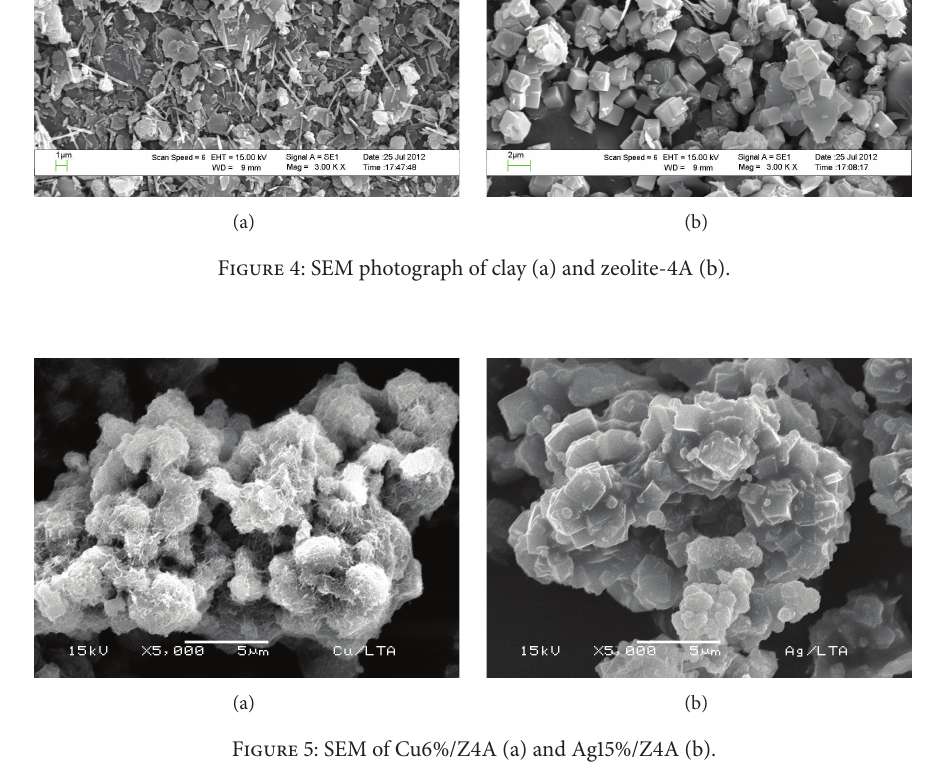
Isotherm linear plot